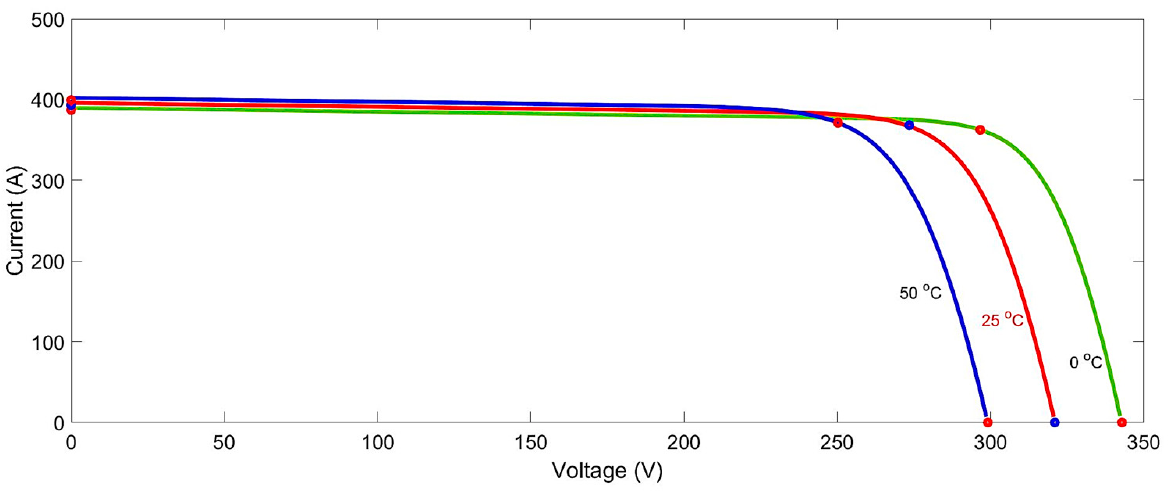
Figure 6. A typical photovoltaic current-voltage curve.